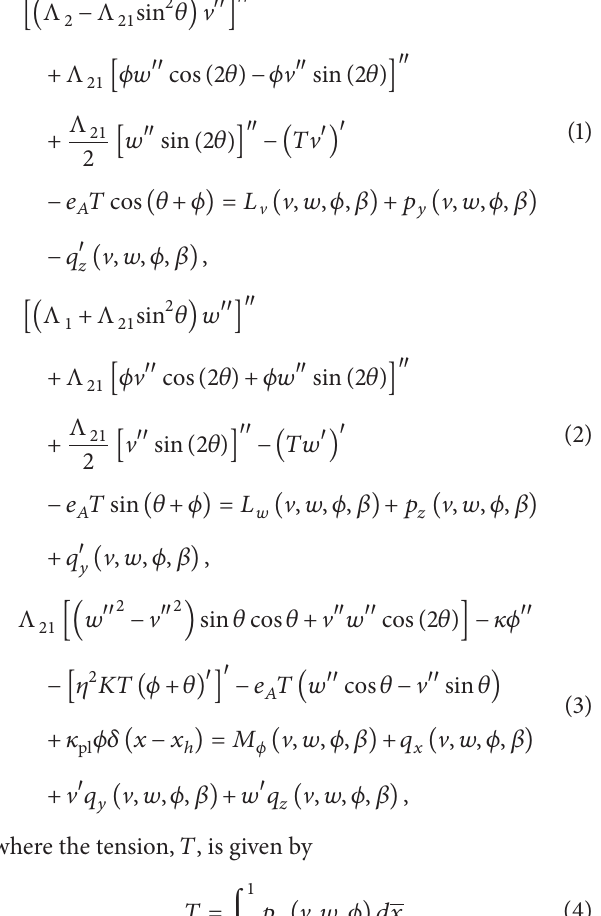
Figure 1: Blade with flap and variable-stiffness devices.